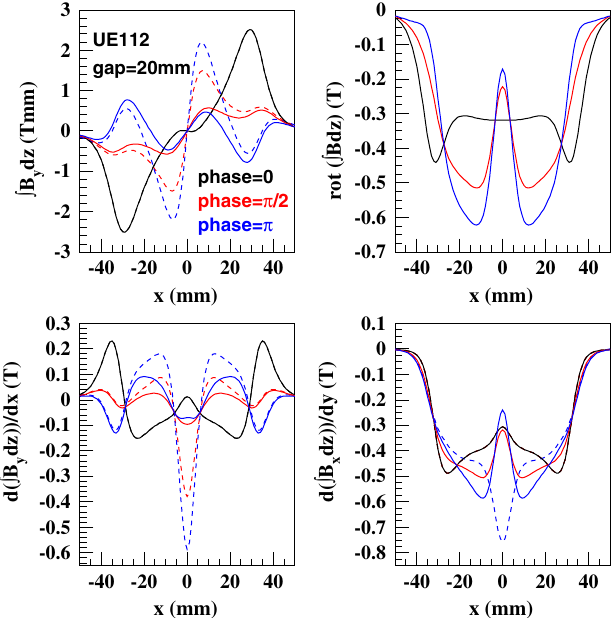
FIG. 5. Top left: Sum of dynamic and static field integrals of the unshimmed device (dashed) and the shimmed device (solid) for various phases. The Fe shims have a negligible effect at phase ¼ 0 . Top right: Rotation of the dynamic field integrals (rotation of the shim contribution is zero) for the phases of the figure top left. Bottom left and right: Contributions to the rotation of the sum of dynamic and static field integrals of the unshimmed device (dashed) and the shimmed device (solid). All data are given for the UE112 at a gap of 20 mm in the